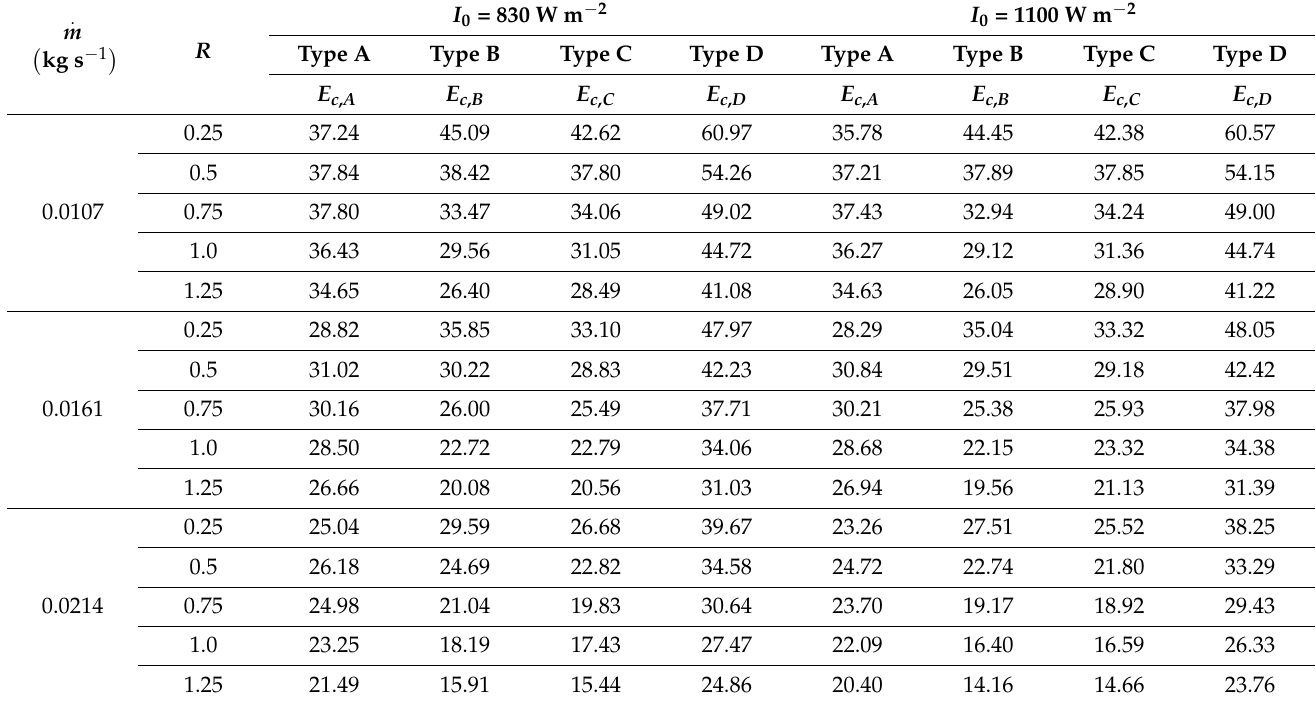
Figure 8. Comparisons of collector thermal efficiency among single-, double- and multi-pass devices. Table 6. Further collector efficiency enhancements of four multi-pass types. ( α = 0.5 and β = 0.5 )